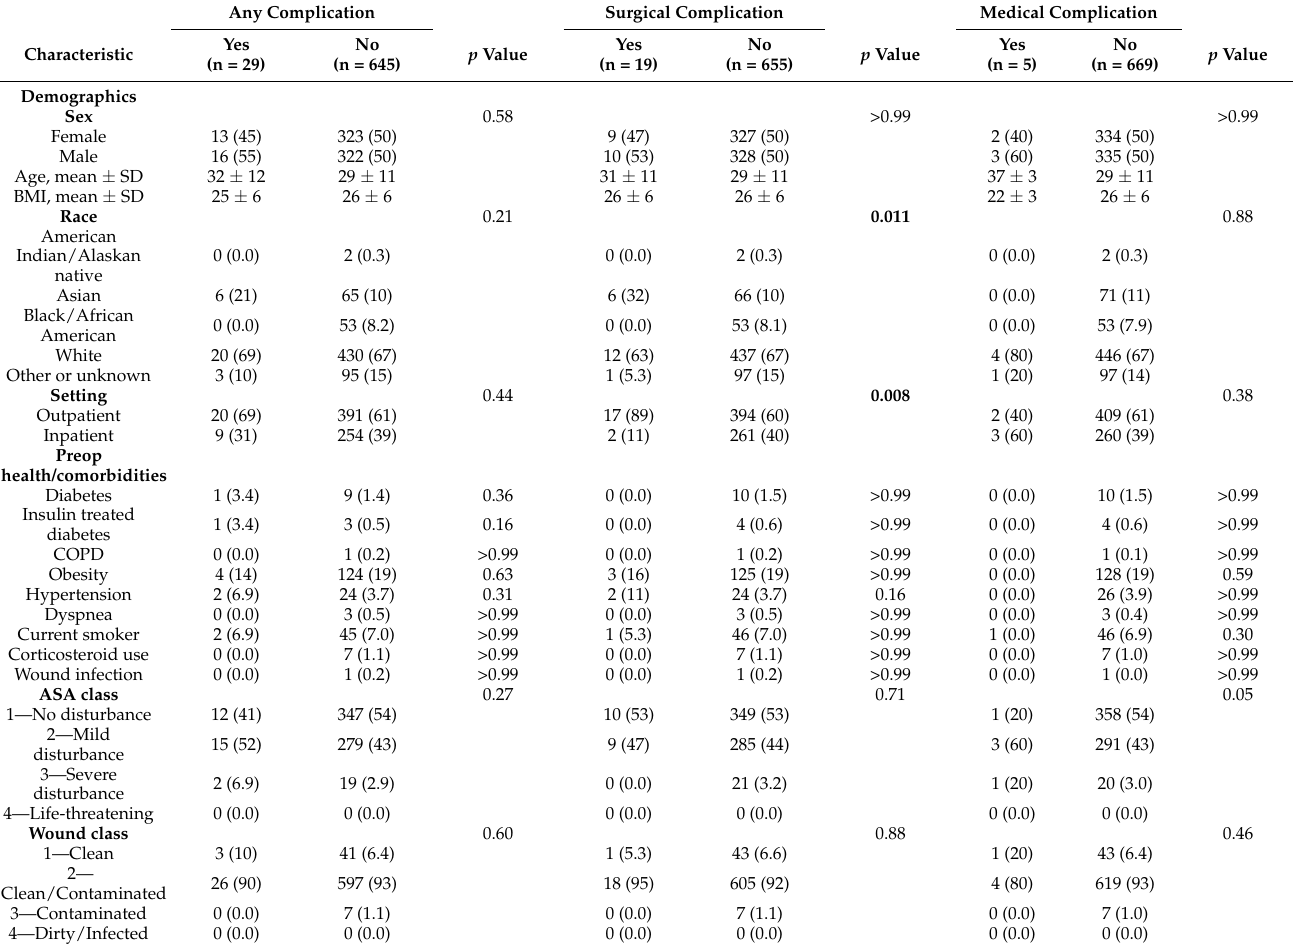
Table 7. Risk factors for complications. Reported as n (%), unless otherwise stated. Statistically significant p values are highlighted in